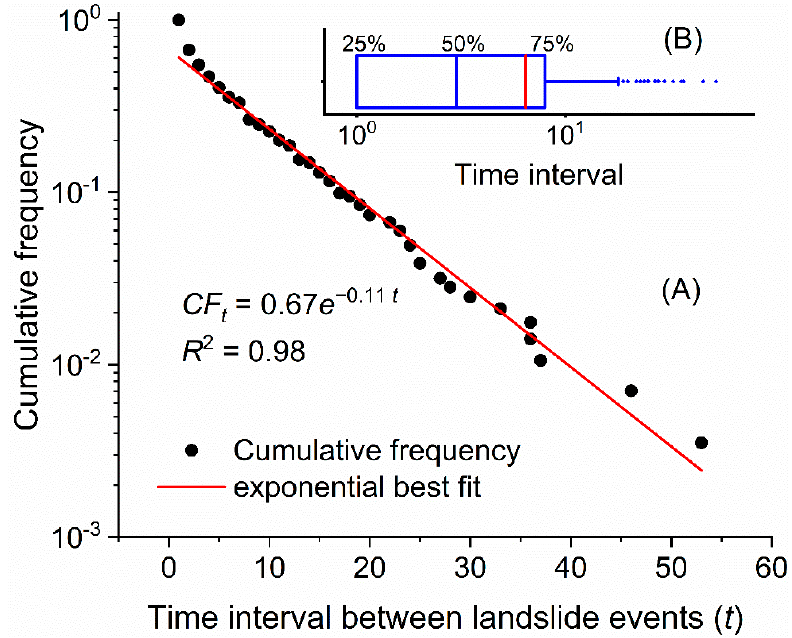
Figure 6. ( A ) Cumulative frequency of time intervals between landslide events from July to October. ( B ) Box plot shows distribution of time intervals.